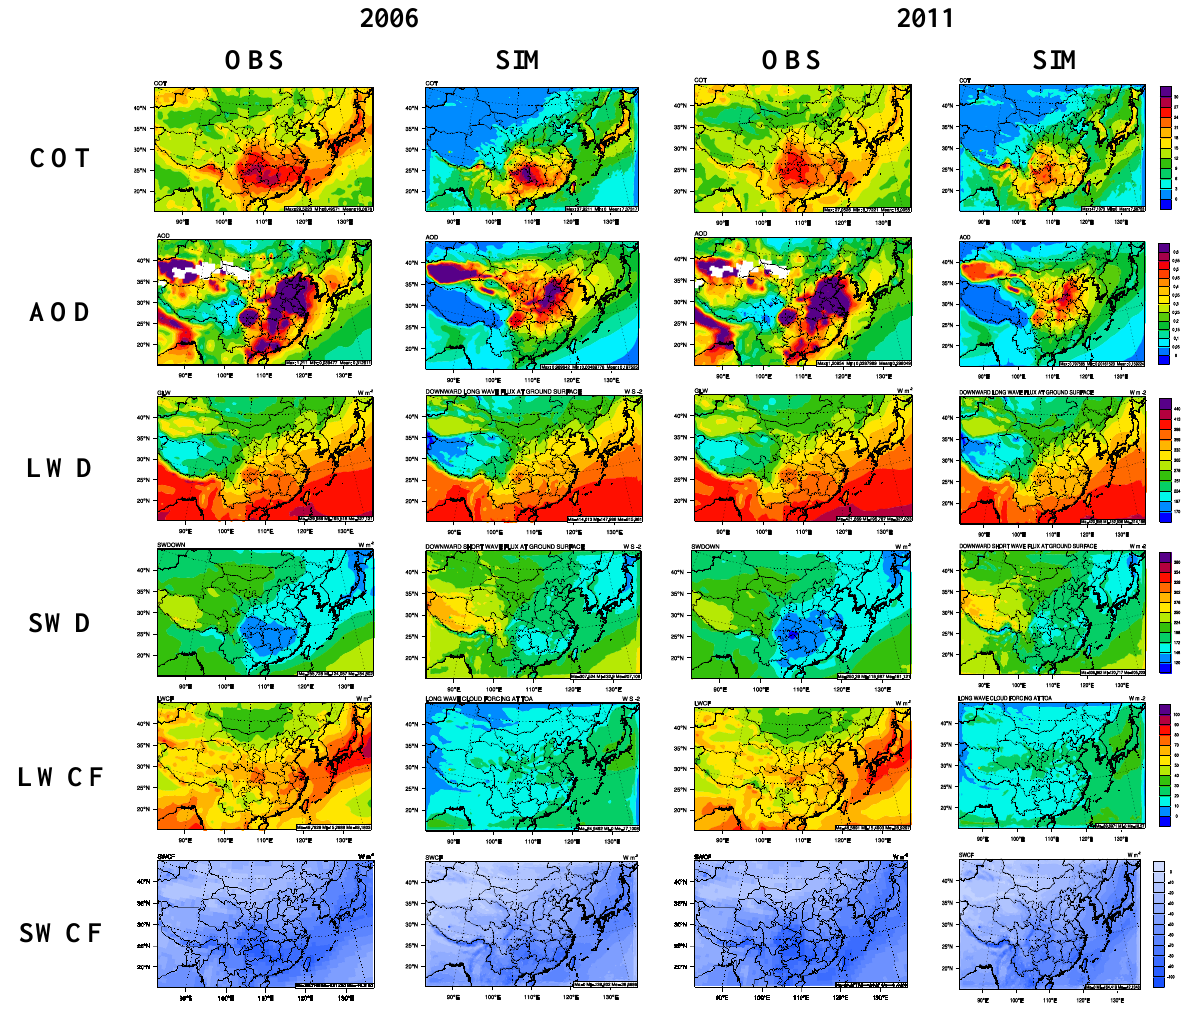
Figure 4. Spatial distributions of annual mean observed and simulated COT, AOD, LWD, SWD, LWCF, and SWCF for the 2006 and 2011 simulations with